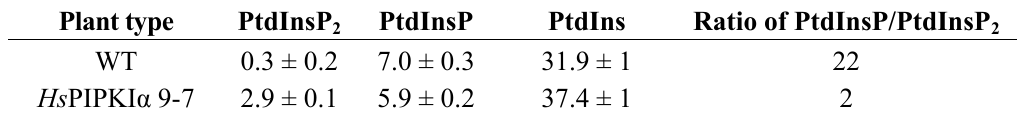
Table 1. [ 3 H] myo -inositol labeled PtdInsP increased in the HsPIPKIα plants. Seedlings 2 were incubated with [ 3 H] myo -inositol, inositol lipids were extracted, separated by thin layer chromatography and quantified using a Bioscan Imaging Scanner. Data are reported as % total [ 3 H] inositol lipid recovered. The data are the mean ± SD of 6 values from two biological replicates. Plant type